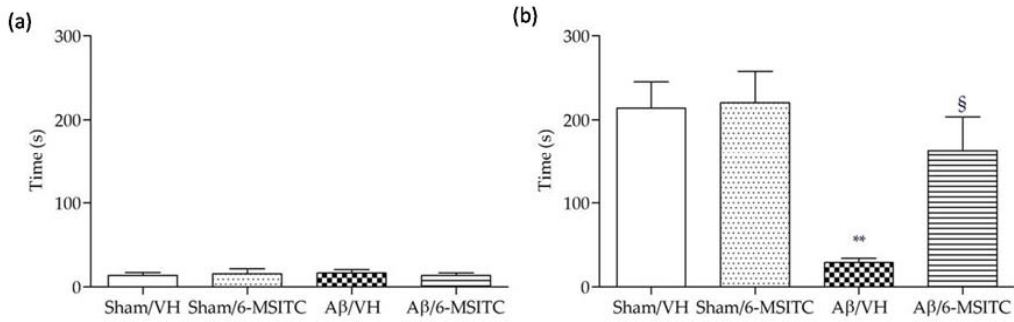
Figure 3. Effects of 6-MSITC (5 mg/kg) on the performance in the training ( a ) and passive avoidance test ( b ) in A β 1-42 O-injected mice. The latency time for entering in the compartment of preference was recorded. Values are expressed as mean ± SEM ( n = 10) (** p < 0.01 vs. Sham/VH group, § p < 0.01 vs. A β /VH; ANOVA, post hoc test Bonferroni).